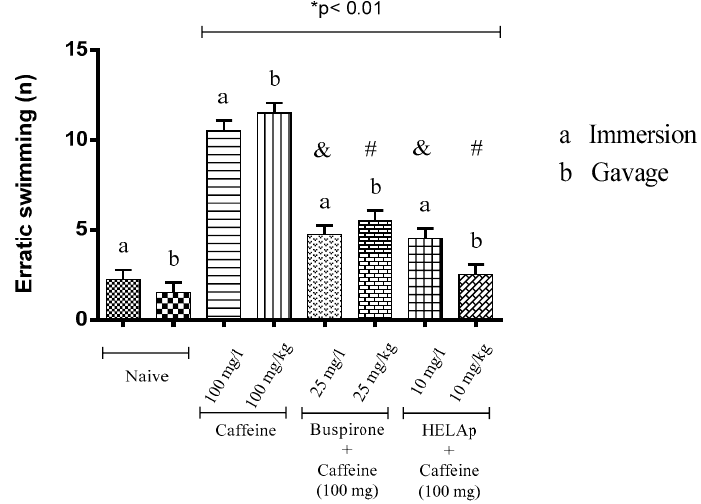
Figure 7. Effects of the hydroethanolic extract from A. polystachya , buspirone, and caffeine on zebrafish behavior in the scototaxis test (erratic swimming) using immersion and oral (gavage) administration. Data are presented as mean ± SEM (n = 4/groups); * p < 0.01 vs. naive fishes; & p < 0.01 vs. caffeine immersion; # p < 0.01 vs. oral caffeine administration. Statistical analysis was performed through one-way ANOVA followed by the post-hoc Tukey test.